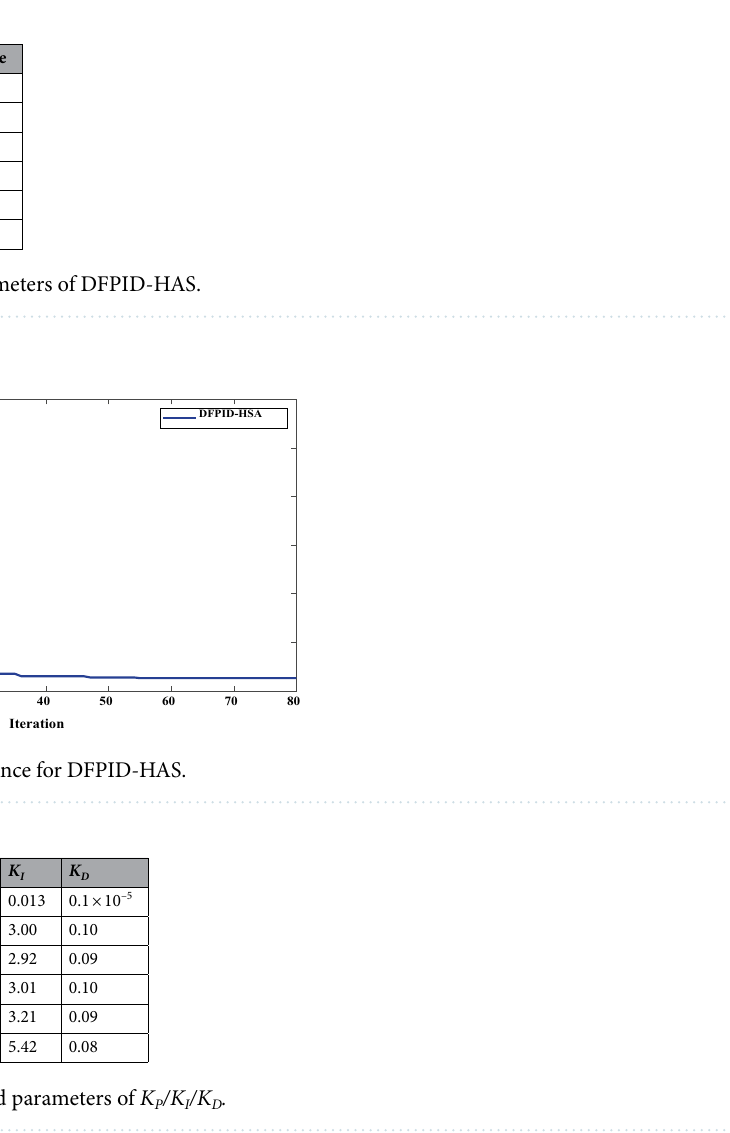
Figure 8. Nyquist diagram of the speed control system for the BLDCM based on DFPID-HSA.